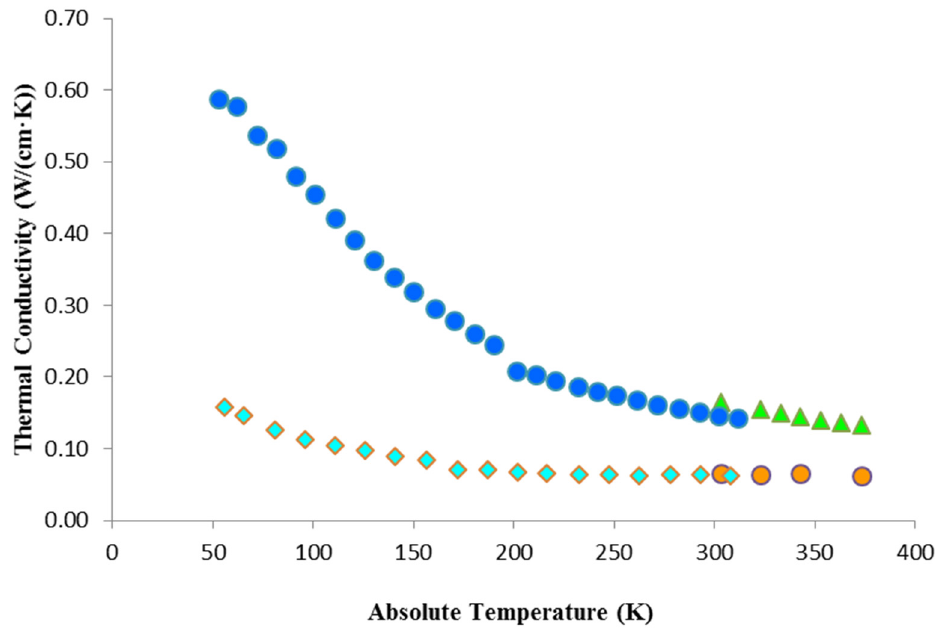
Figure 6. Thermal conductivity as a function of absolute temperature for the sesquioxide material Sc 2 O 3 , for undoped hydrothermal (blue) [43] and Czochralski (green) [44] grown single-crystals, 3 at. % Er doping (light blue) [44], and 2.8 at. % Yb doping (orange) [44].